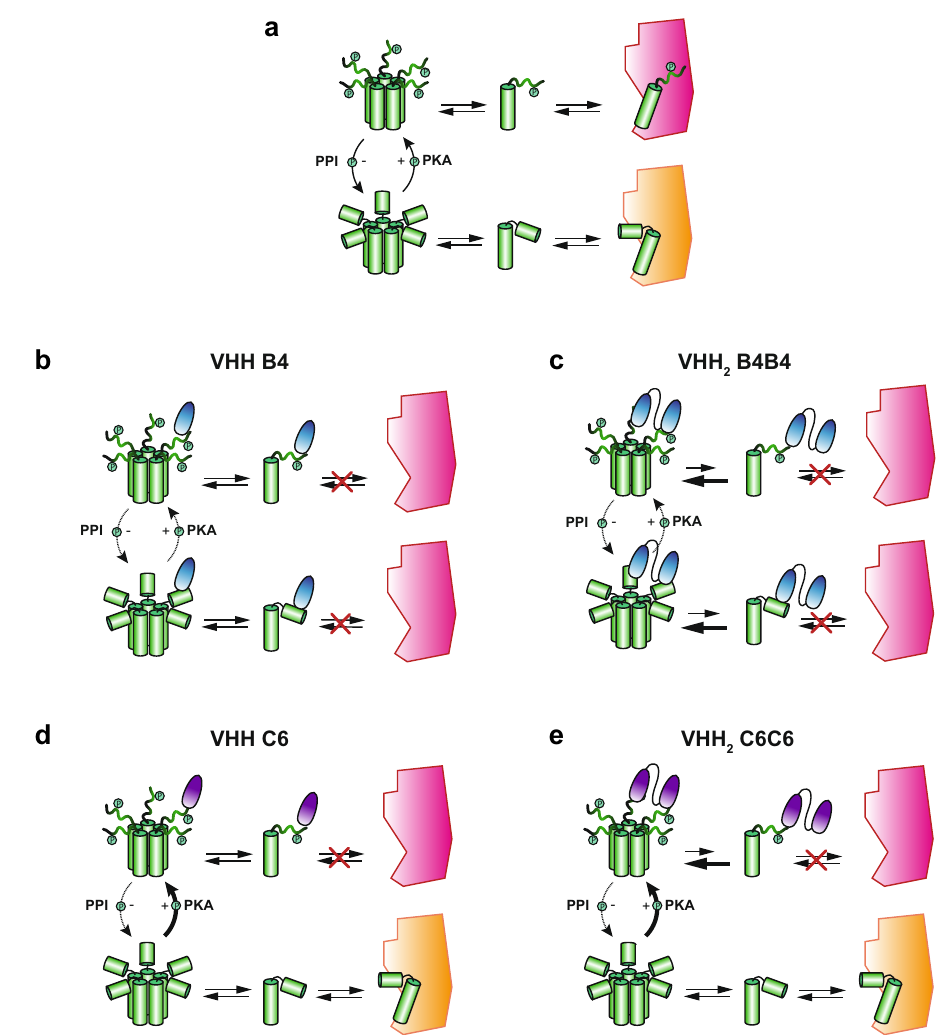
Fig. 7 Molecular mechanism of action of the different PLN-speci fi c intrabodies. a Molecular mechanism of PLN function. Pentameric PLN (green) is in dynamic equilibrium with PLN monomers, which bind and inhibit SERCA2a (inhibited SERCA2a, yellow; activated SERCA2a, red). PKA phosphorylates PLN and PPI dephosphorylates PLN. Phosphorylated PLN monomers are able to bind to active SERCA2a. b VHH B4 and c VHH 2 B4B4 bind to all forms of PLN, but with differing af fi nities. This binding results in steric hinderance of PLN or pS16 PLN to bind to SERCA2a, leading to activation of SERCA2a. VHH 2 B4B4 additionally shifts the equilibrium toward pentameric species of PLN (indicated by a larger arrow pointing towards the shift in the equilibrium). Steric hinderance may lead to inhibition of PLN phosphorylation by PKA, the binding of the pS16 PLN species by VHH B4 or VHH 2 B4B4 may also protect pS16 PLN from dephosphorylation by PPI. d The VHH C6 and e VHH 2 C6C6 bind only to phosphorylated PLN and phosphorylated PLN 5 , leaving the binding equilibria of the unphosphorylated PLN state unaltered. Steric hinderance inhibits the association of pS16 PLN to SERCA2a, the free SERCA2a can bind to unphosphorylated PLN leading to SERCA2a inactivation. This is however offset by protection of PLN dephosphorylation by VHH C6 or VHH 2 C6C6 from PPI activity and accumulation of pS16 PLN. A dotted arrow for the PPI activity and a thicker arrow for the kinase reaction indicate this perturbation of the PLN phosphorylation balance. VHH 2 C6C6 additionally shifts the equilibrium towards pS16 PLN 5 due to the stabilisation of the pentameric form (indicated by a larger arrow pointing towards the shift in the